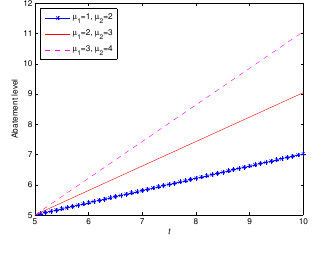
Figure 6. The effects of µ i ( i = 1 , 2) Figure 7. The effects of µ i ( i = 1 , 2) on Wanzhou District’s abatement levels on Kaizhou District’s abatement levels of of cooperative transboundary pollution cooperative transboundary pollution problems. problems.